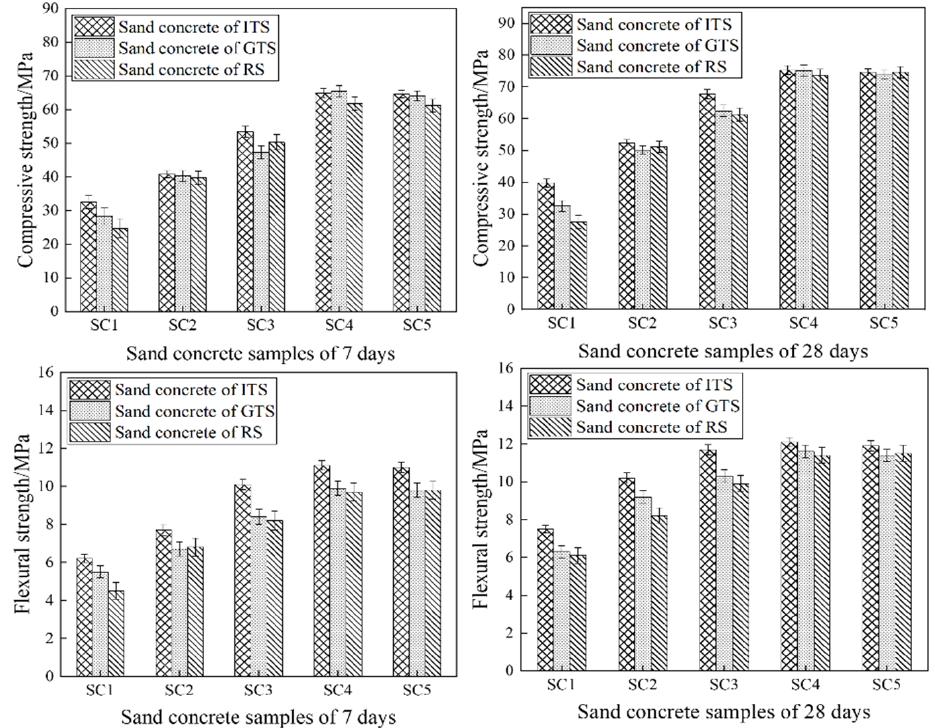
Figure 7. Compressive strength and flexural strength of sand concrete.